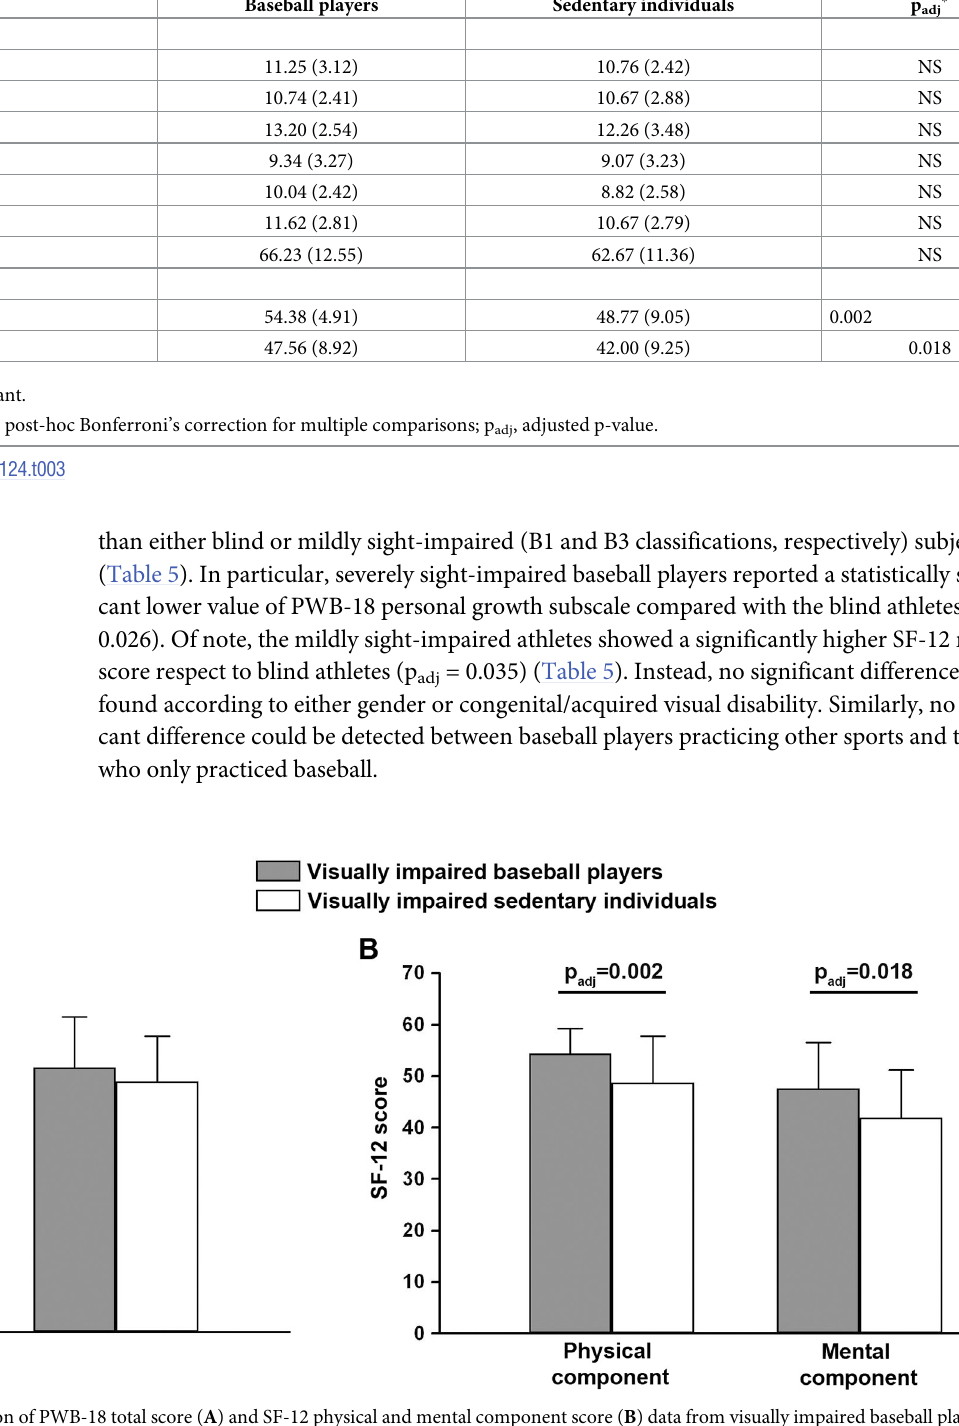
Fig 1. Comparison of PWB-18 total score ( A ) and SF-12 physical and mental component score ( B ) data from visually impaired baseball players and visually impaired sedentary individuals. Data are mean ± SD. Student’s t -test for unpaired data with post-hoc Bonferroni’s correction for multiple comparisons was used for statistical analysis; p adj , adjusted